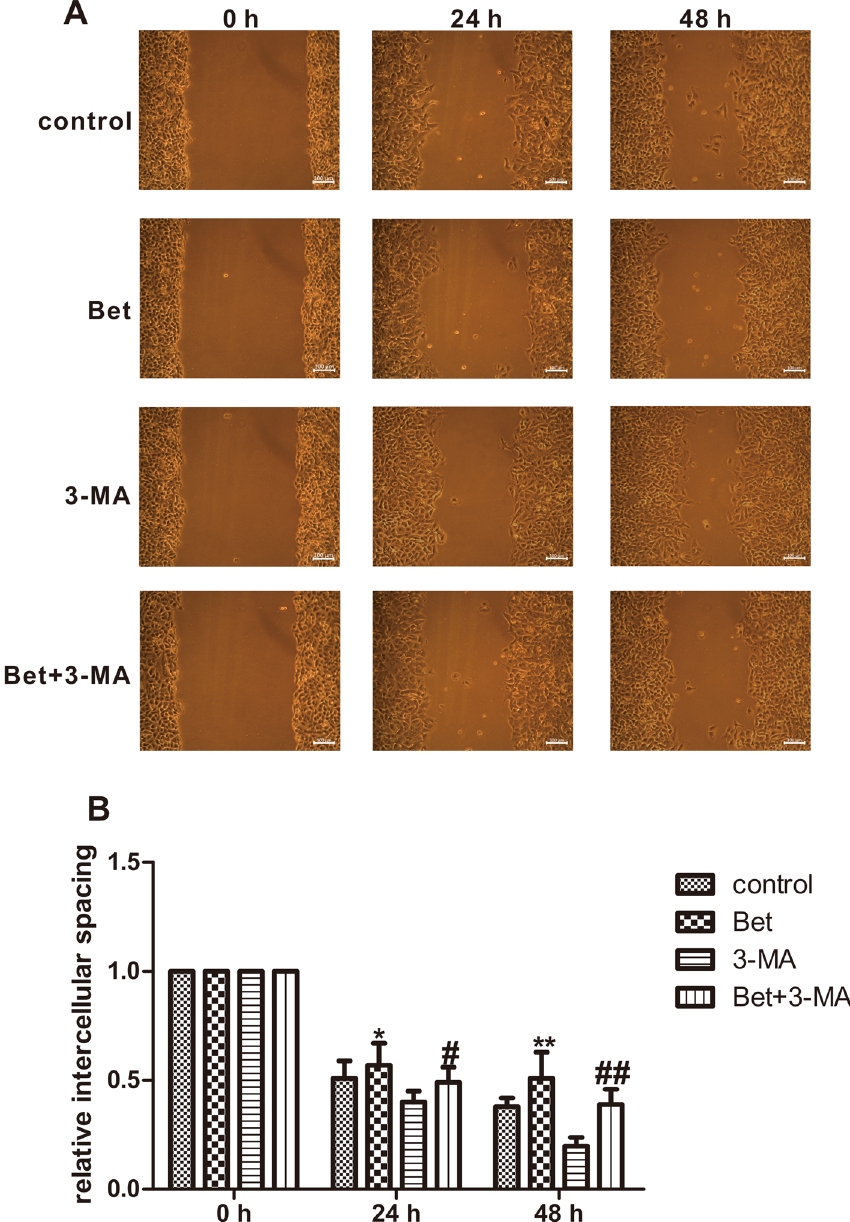
Figure 6. Autophagy mediated the effect of betulinaldehyde on migration of A549 cells. ( A ) A549 cells were treated with betulinaldehyde (20 μM) for 24 h, with or without 3-MA, and the intercellular spacing was observed at different time points. ( B ) The statistical analyses of the migration ability. All values are expressed as the mean ± SD ( n = 3). Statistical significance was evaluated by one-way analysis of variance followed by LSD for post hoc test. * P < 0.05, ** P < 0.01 versus control group, # P < 0.05, ## P < 0.01 versus Bet group (Bet = betulinaldehyde, 3-MA = 3-methyladenine). Scale bar, 100